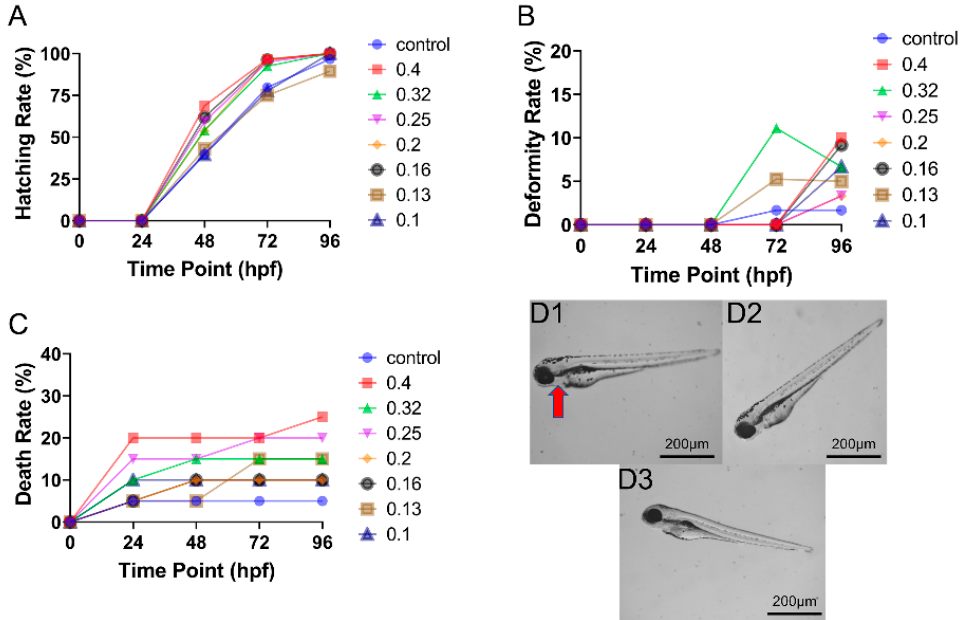
Figure 2. Concentration- and time-dependent effects of ENF on zebrafish embryo development (n = 60). ( A ) Time–response curves for hatching rate at all tested doses. ( B ) Time–response curves of deformity rate at all tested doses. ( C ) Time–response curves of death rate at all tested doses. ( D ) Typical deformities induced by ( D1 ) 0.40 mg/L, ( D2 ) 0.20 mg/L, and ( D3 ) 0.10 mg/L ENF at 96 hpf. Red arrow indicates a region of pericardial oedema.